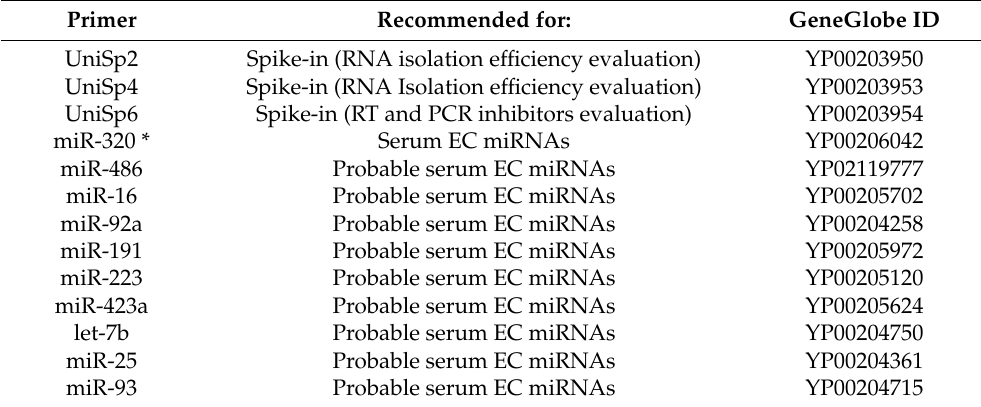
Table 2. QPCR-specific pair primers. The resuspended primer mix contains both forward and reverse sequences. * Previous studies have identified miR-320 as the best EC miRNA in SAR dog